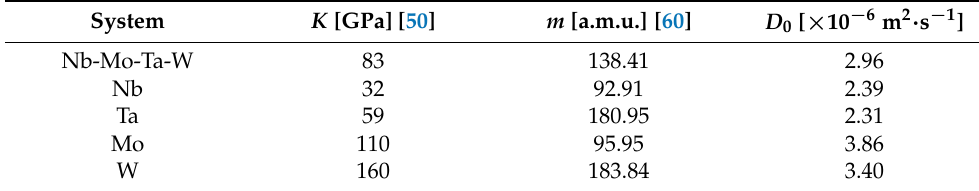
Table 7. Parameters and pre-exponential factors used in calculation of diffusivity.